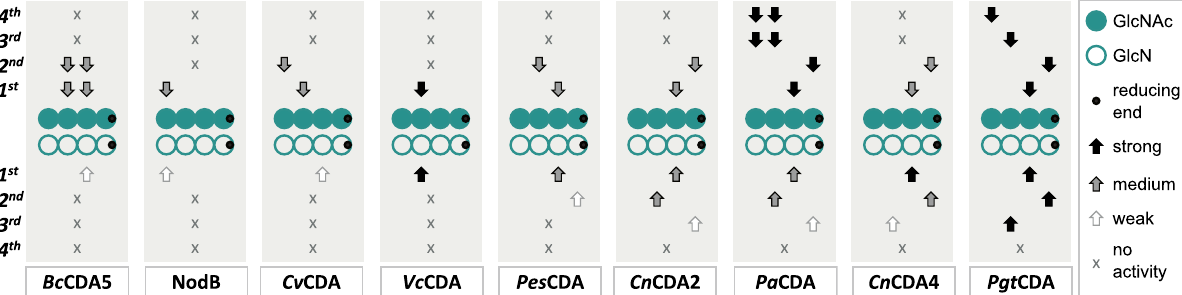
Figure 3. Mode of action of different CDAs (bacterial, viral, and fungal) on the chitin tetramer (A4, [GlcNAc] 4 , filled circles) shown in the upper part, as well as on the chitosan tetramer (D4, [GlcN] 4 , open circles) in the lower part. The reducing end of the (pa)COS always points to the right and is marked by a black circle. No activity is symbolized by an x, weak activity by an unfilled arrow, medium-strong activity by a grey-filled arrow, and strong activity by a black-filled arrow; arrows point to the unit of the (pa)COS which is preferentially de- or N- acetylated during either the 1st, 2nd, 3rd, or 4th attack by the different enzymes. Data summarized in this figure have been generated by (semi-)quantitative HILIC-ESI–MS analysis followed by 18 O-labelling of the reducing end and MS/MS